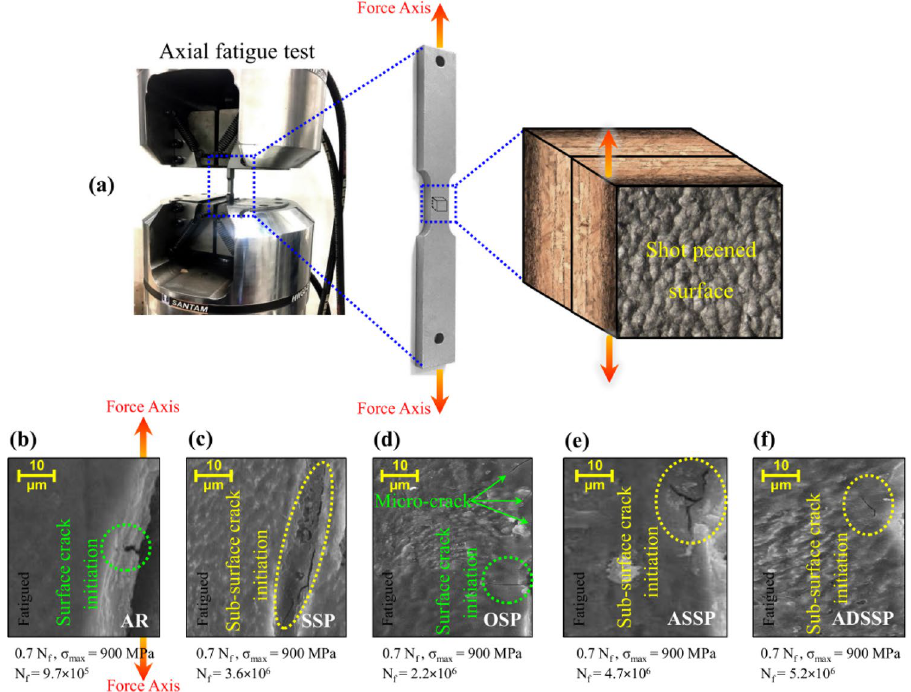
Figure 9. ( a ) Schematic illustration of considered scan area from analysing the crack initiations in all sets of specimens. Crack initiations sites in ( b ) AR, ( c ) SSP, ( d ) OSP, ( e ) ASSP and ( f ) ADSSP